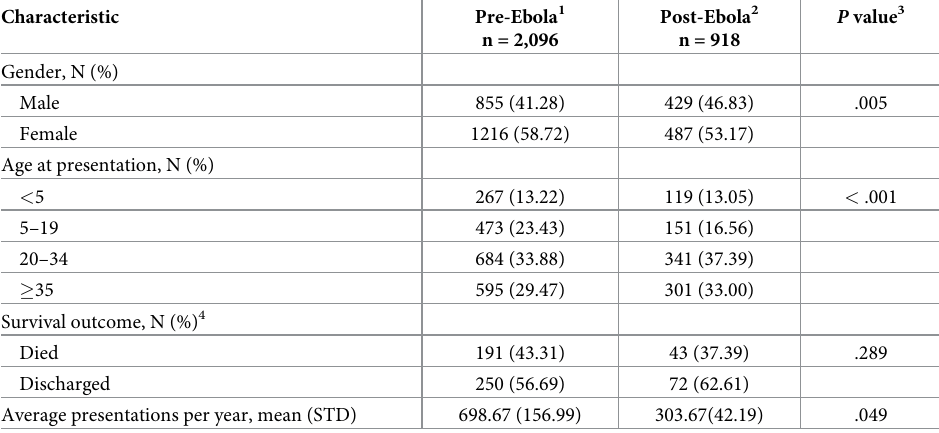
Died Average presentations per year, mean (STD)